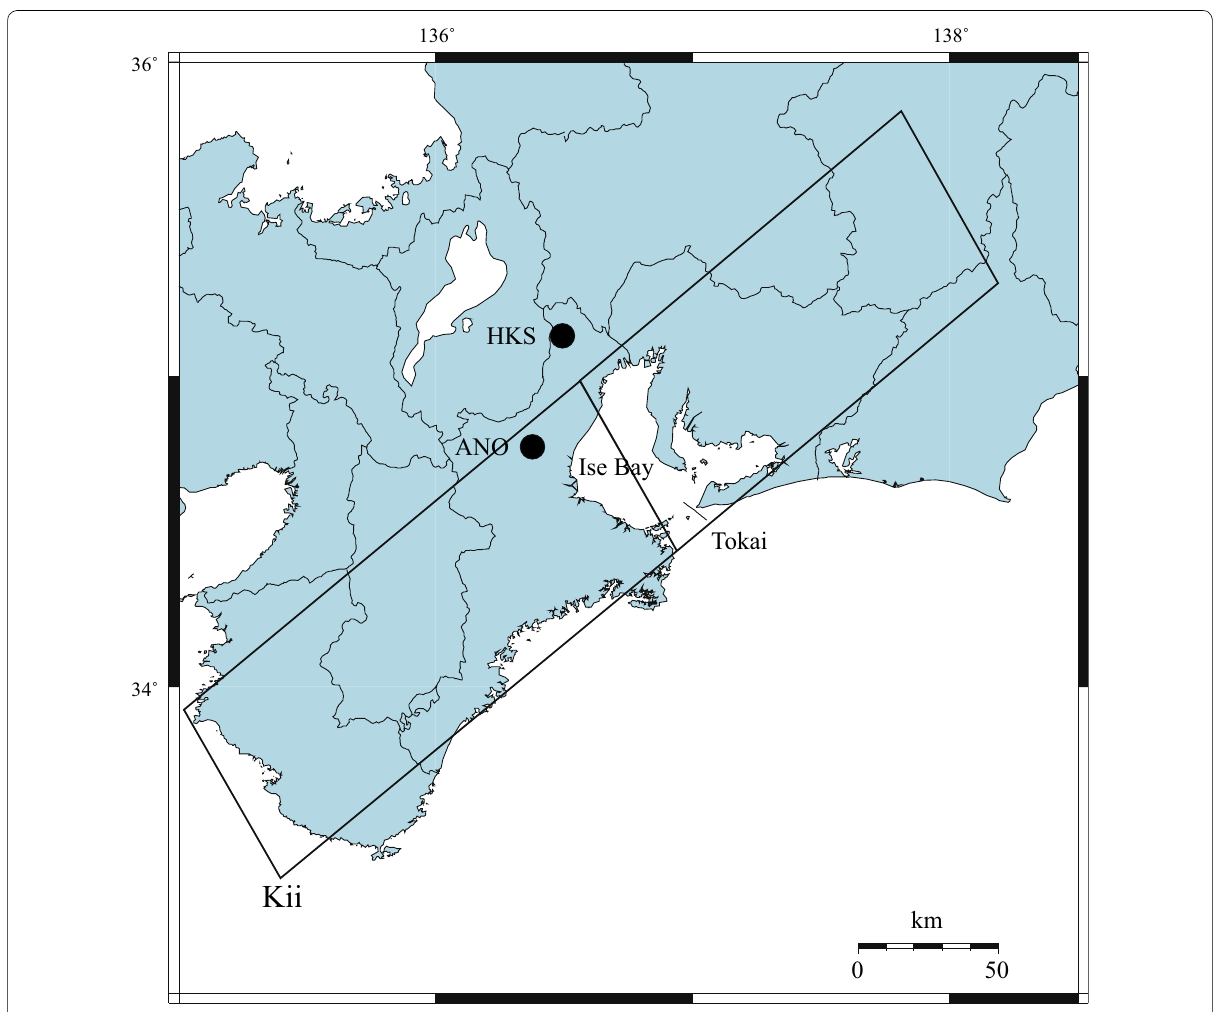
Fig. 1 Locations of the Hokusei (HKS) and ANO observation sites. The Kii and Tokai tremor occurrences (see Fig. 5) were counted within the parallelograms labeled ‘Kii’ and ‘Tokai’,